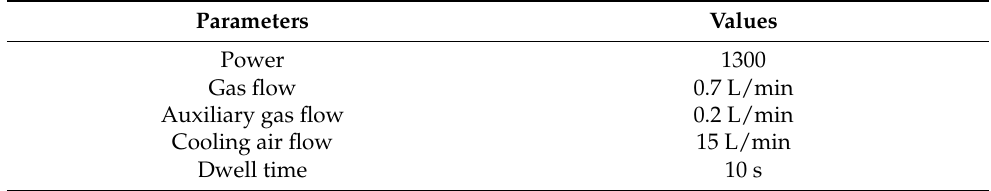
Table 2. Operating parameters for ICP-AES.